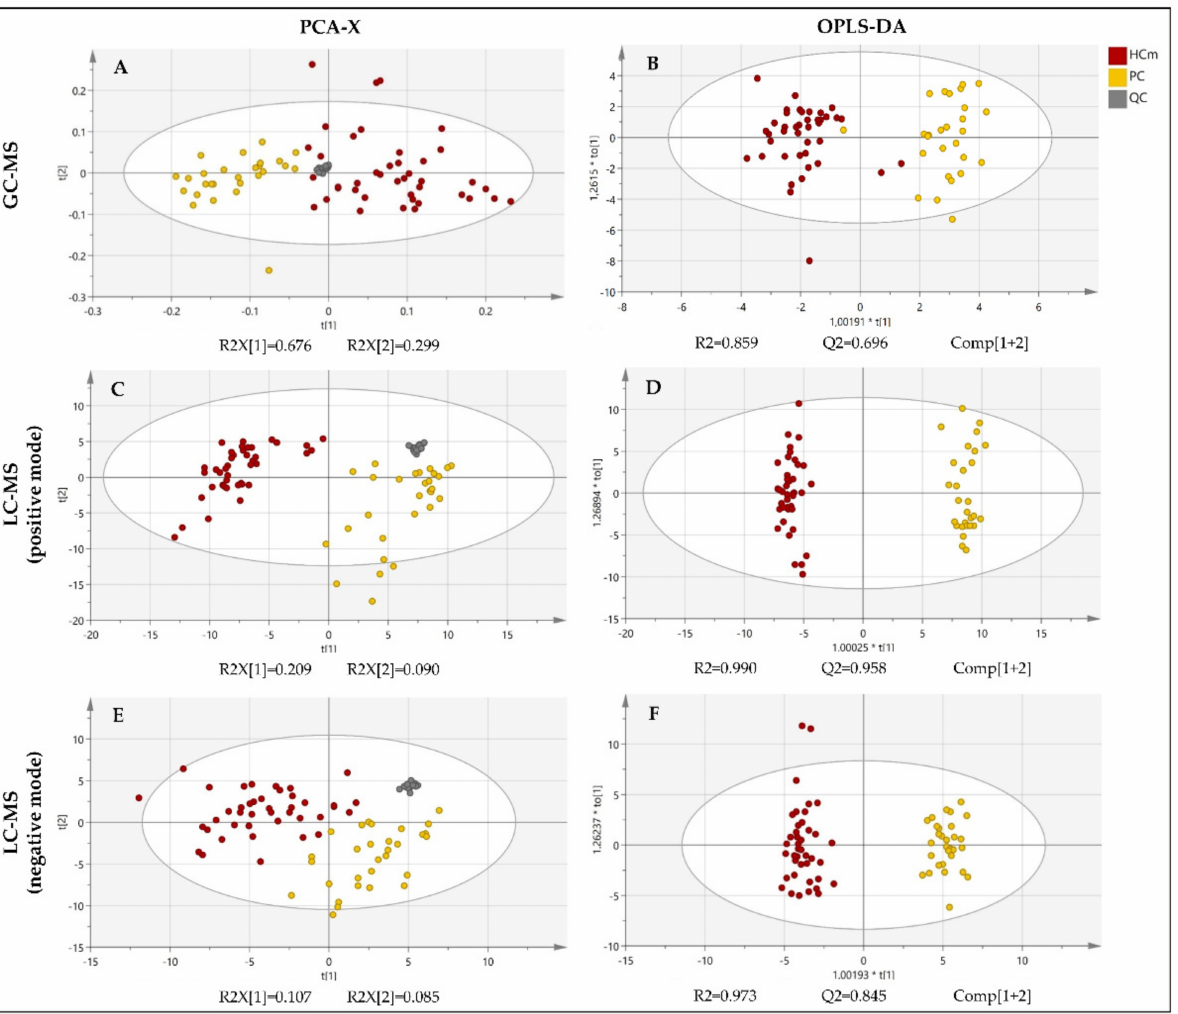
Figure 2. PCA and OPLS-DA score plot of the untargeted metabolomics analysis of plasma samples from patients diagnosed with prostate cancer (PC) and healthy male control subjects (HCm). Plots were obtained using SIMCA-P+ software (version 15.0.2.5959, Umetrics, Umea, Sweden). ( A ) PCA score plot for the GC-MS analysis; ( B ) OPLS-DA score plot fort the GC-MS analysis; ( C ) PCA score plot fort the LC-MS(+) analysis; ( D ) OPLS-DA score plot fort the LC-MS(+) analysis; ( E ) PCA score plot fort the LC-MS( − ) analysis; ( F ) OPLS-DA score plot fort the LC-MS( − ) analysis; QC = quality control. t[1]: the first principal component, t[2]: the second principal component, to[1]: the first orthogonal component, *: multiplication